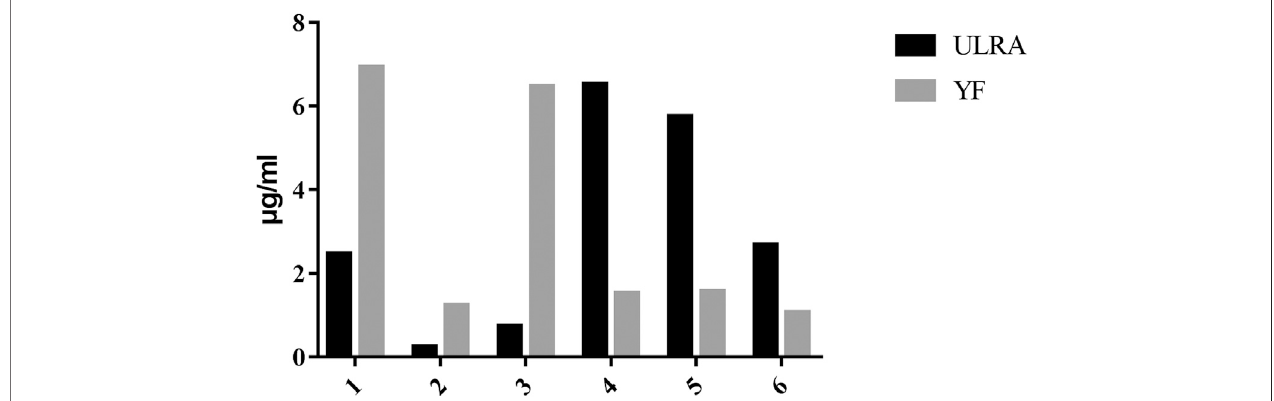
FIGURE 3 | Results of content determination of six alkaloids ( n (cid:2) 3). (1), Benzoylmesaconine; (2), Benzoylhypaconine; (3), Benzoylaconine; (4), Mesaconitine; (5), Aconitine; (6),